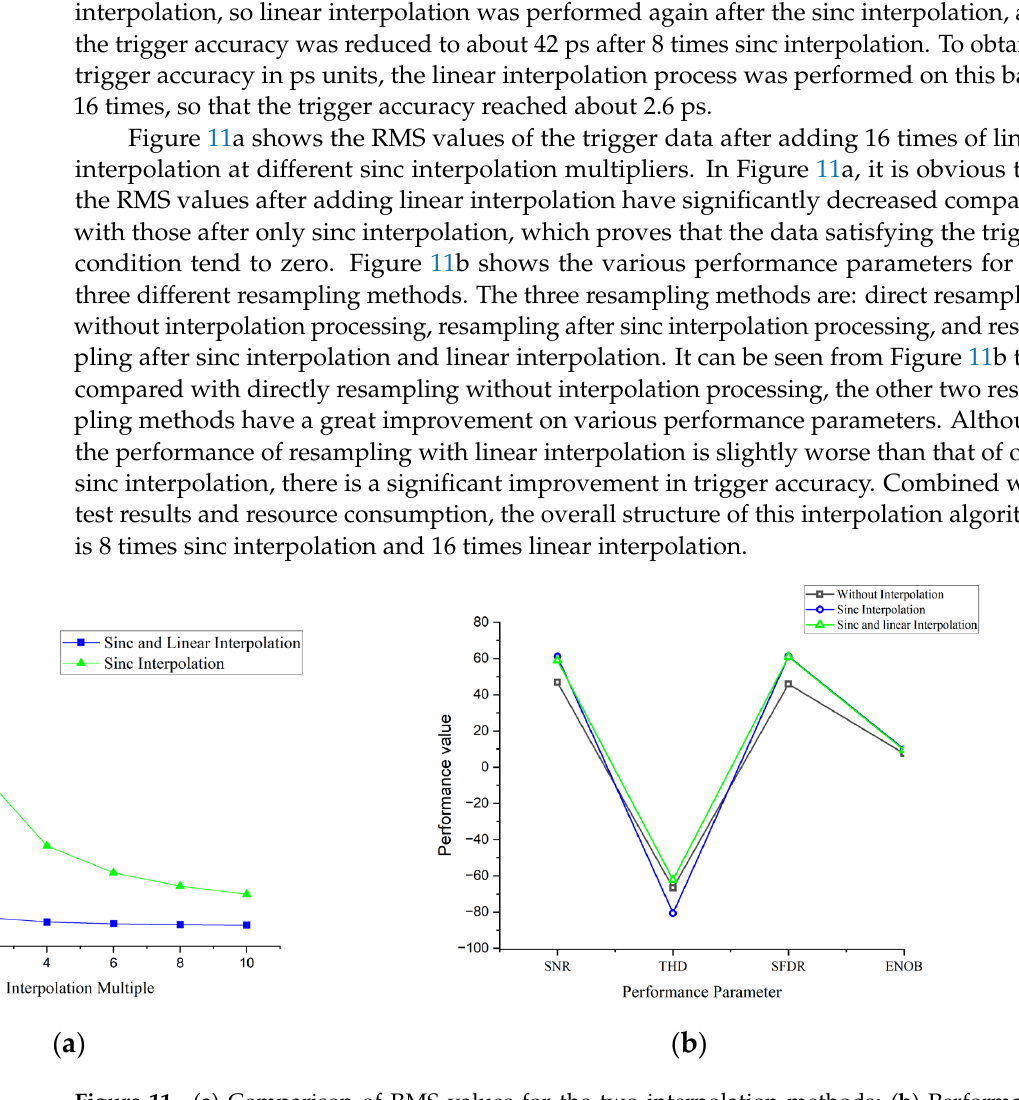
Figure 11. ( a ) Comparison of RMS values for the two interpolation methods; ( b ) Performance comparison of three resampling methods.